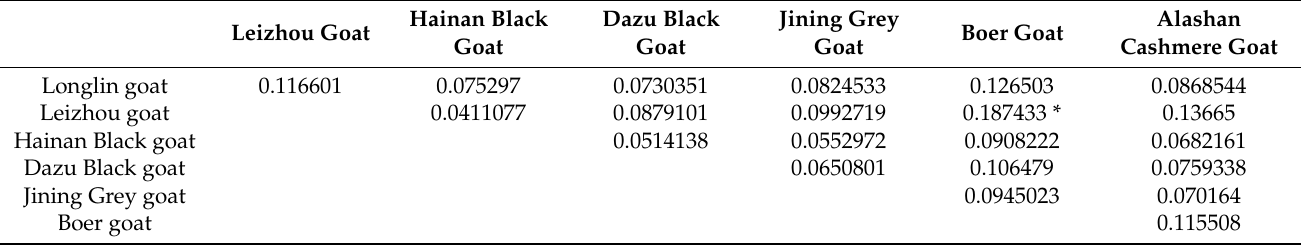
Table 3. Statistics of the Fst results between